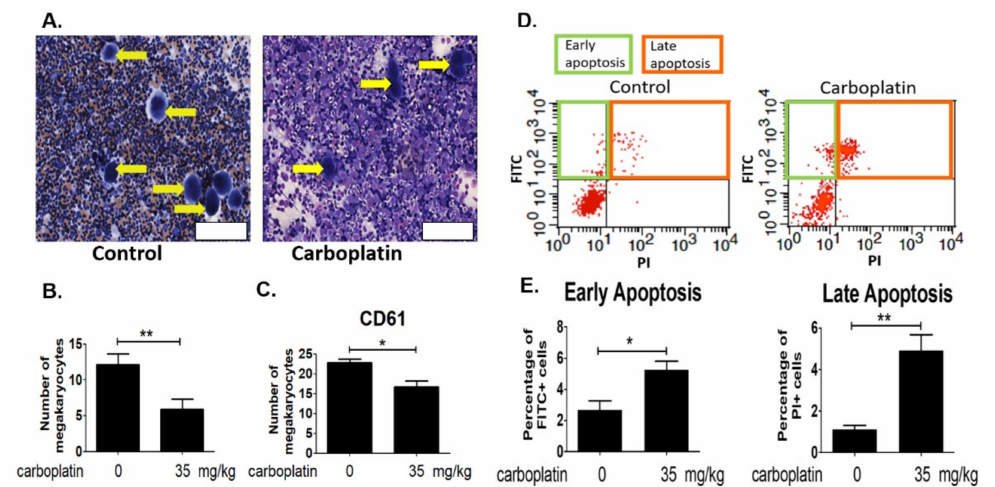
Figure 2. Number of megakaryocytes decreased after carboplatin treatment in vivo. Bone marrow washout from control and 35 mg/kg carboplatin-treated rat at the sixth day were used for the